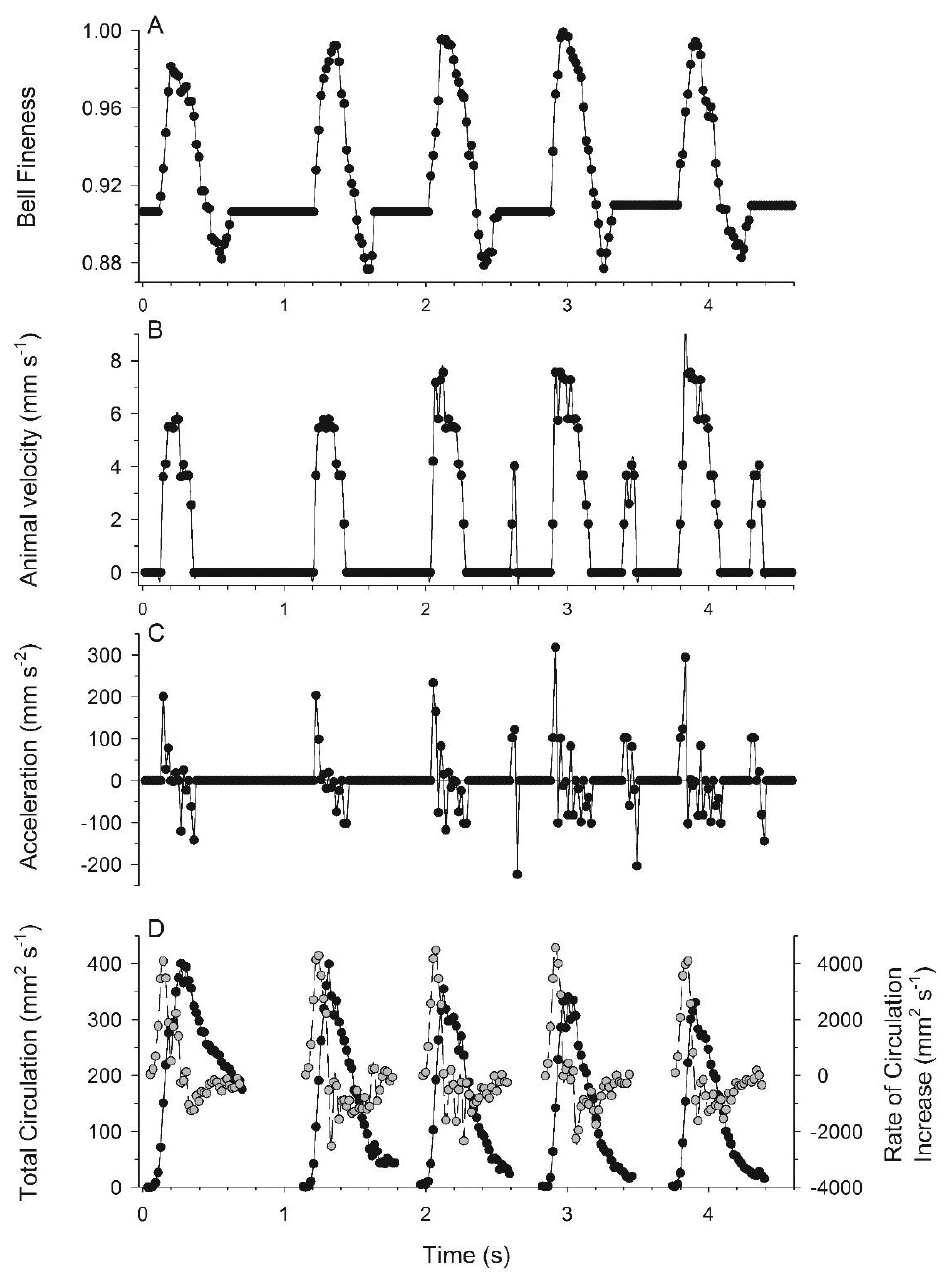
Figure 2. Swimming movements and vortex circulation patterns during linear swimming by the hydromedusa Eutonina indicans . ( A ) Bell fineness patterns over 5 consecutive pulsation cycles for a 1.01 cm bell diameter medusa; ( B ) body velocity; ( C ) acceleration; and ( D ) total starting vortex circulation (dark circles) and the rate of change in total starting vortex circulation (grey circles) during the same intervals.